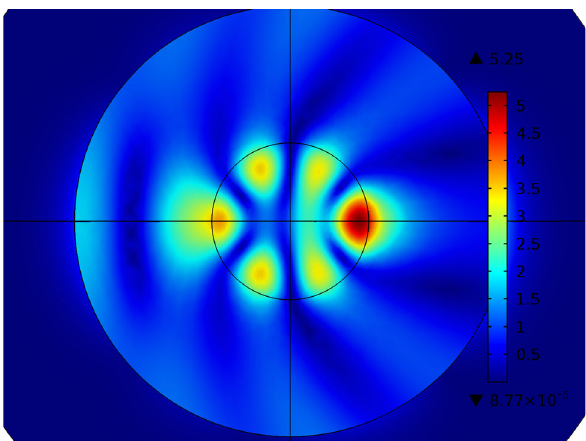
Fig. 6 FEM simulation of electric fi eld distribution on XOZ plane for a Nb 2 O 5 nanocrystal with the diameter of 400 nm (the aggregated nanoparticles) as the incident light propagates along X axis. ( λ = 526